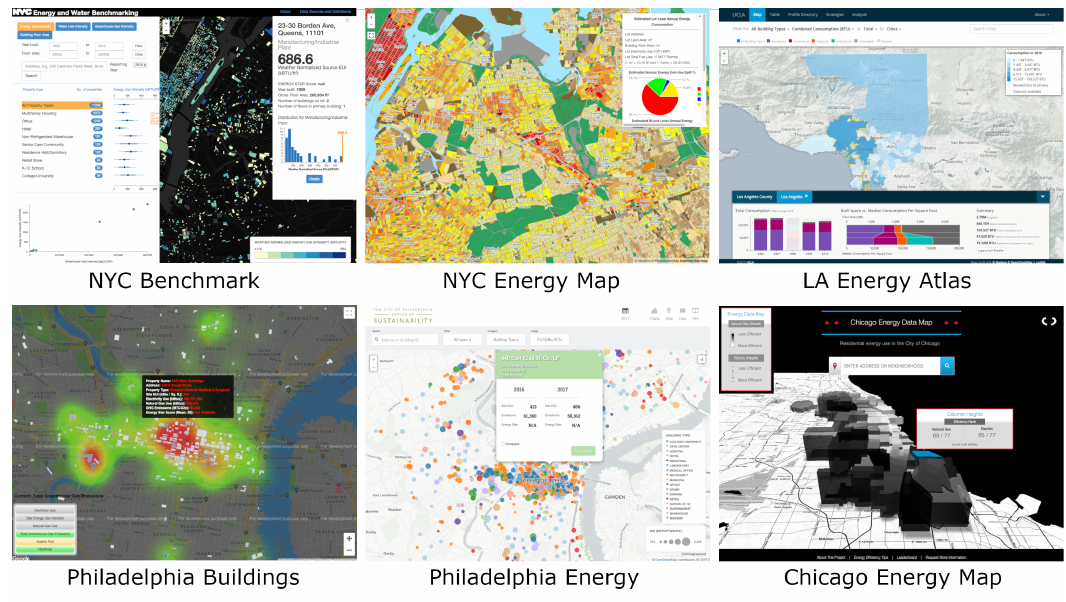
Figure 2. Snapshots from the state of the art in urban energy visualization